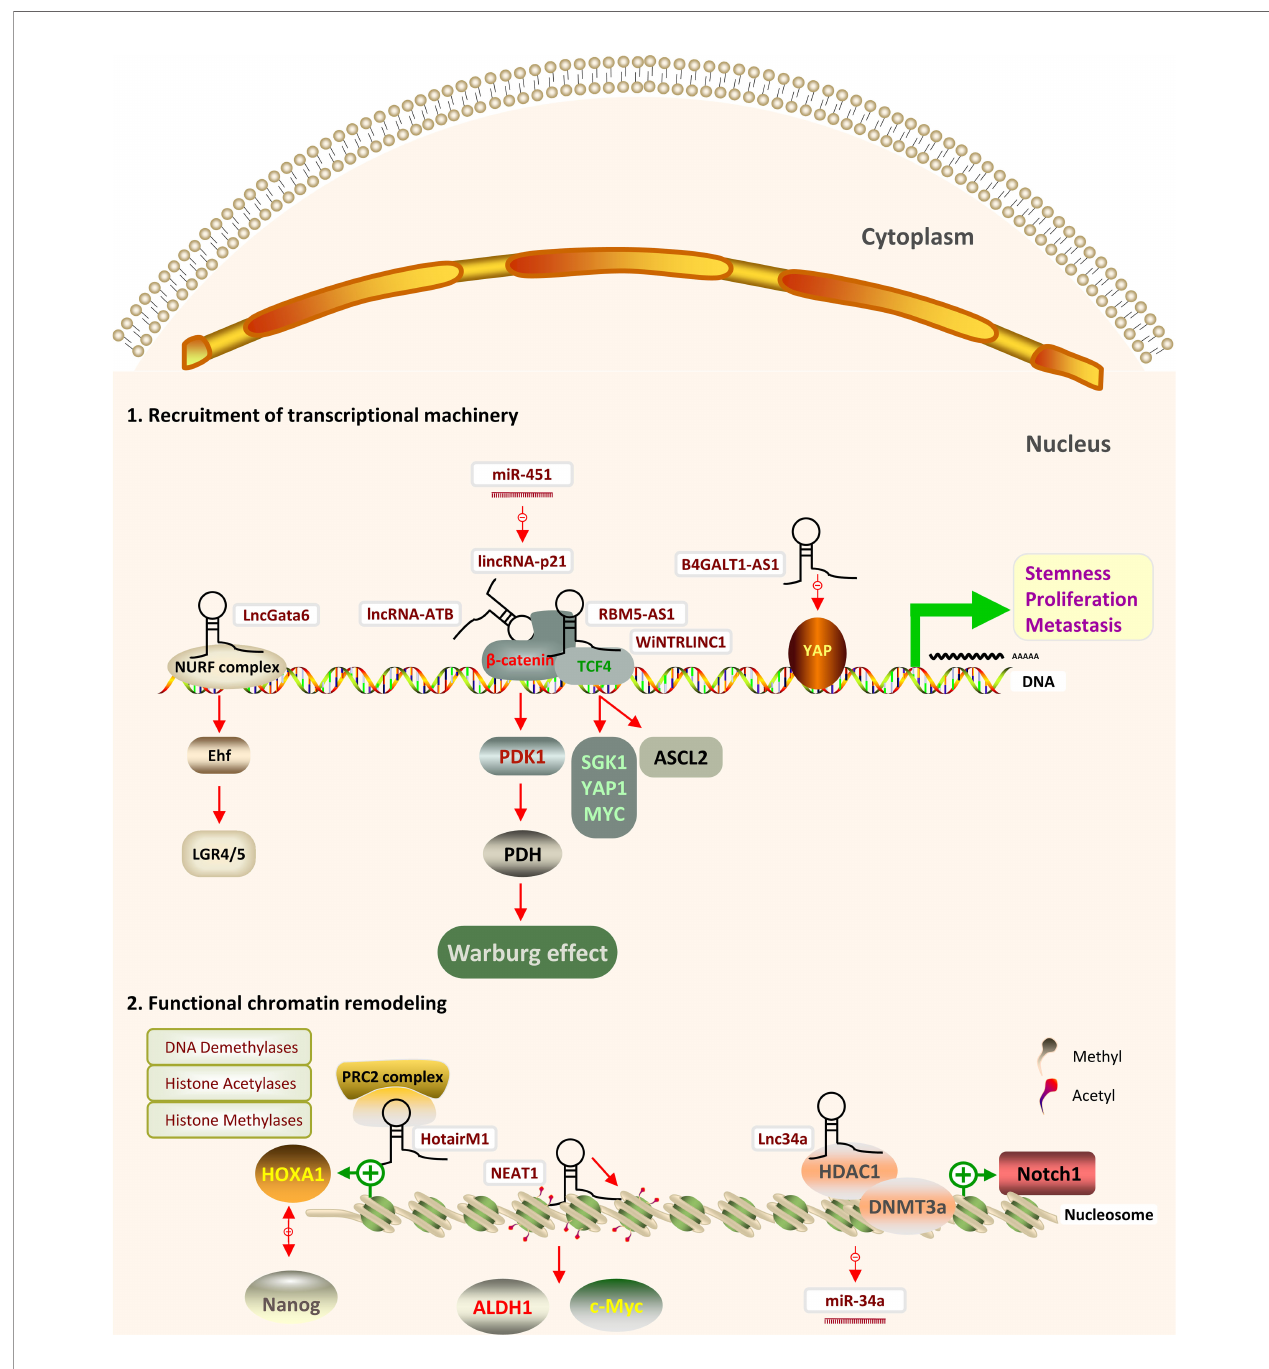
FIGURE 2 | Schematic representation of the effects of nuclear lncRNAs through epigenetic modi fi cations and transcription factors in CRCSCs and the downstream pathways and mediators involved. (1) LncRNAs can modulate transcription by transcription factors (TF) (2) LncRNAs can regulate DNA and histone modifying proteins by recruiting chromatin remodeling